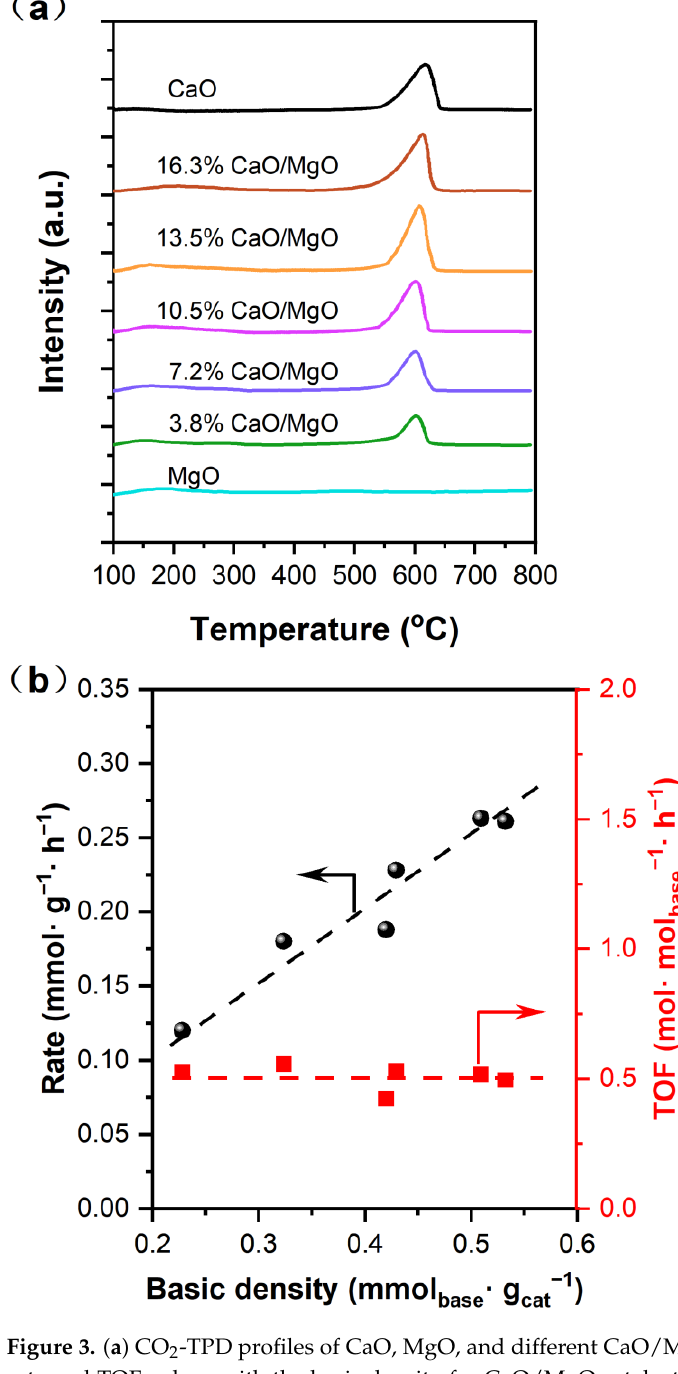
Figure 3. ( a ) CO 2 -TPD profiles of CaO, MgO, and different CaO/MgO catalysts, ( b ) correlation of rate and TOF values with the basic density for CaO/MgO catalysts. Reaction conditions: 120 °C, 0.3